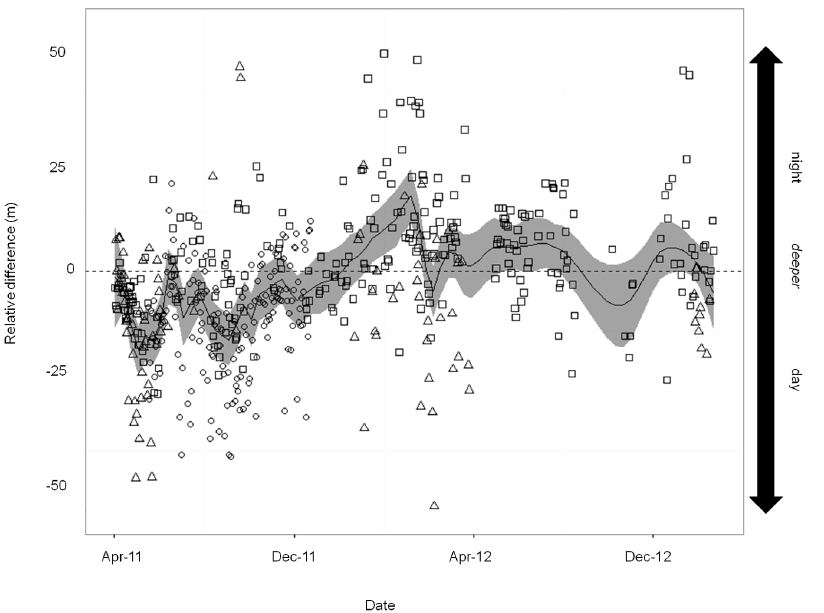
Figure 6. Passive telemetry: seasonal shifts in diel average depth. The relative difference in the average daily period (night and day) depth for each of the three individuals (assigned with different markers - see Fig 6) across the monitoring period. Values below the x origin indicate days where daytime depths were deepest while values above the x origin indicate days where night time depths were the deepest.